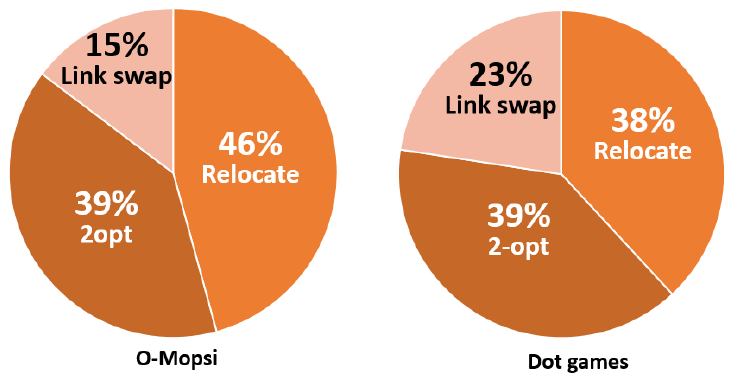
Figure 26. Share of improvement by all three methods for Tabu search.